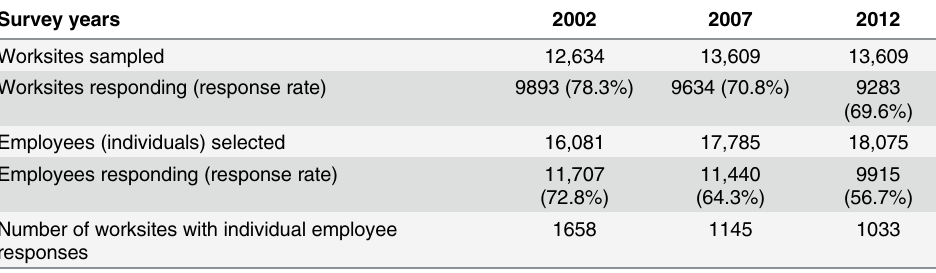
Table 1. Study subjects: worksites and individuals